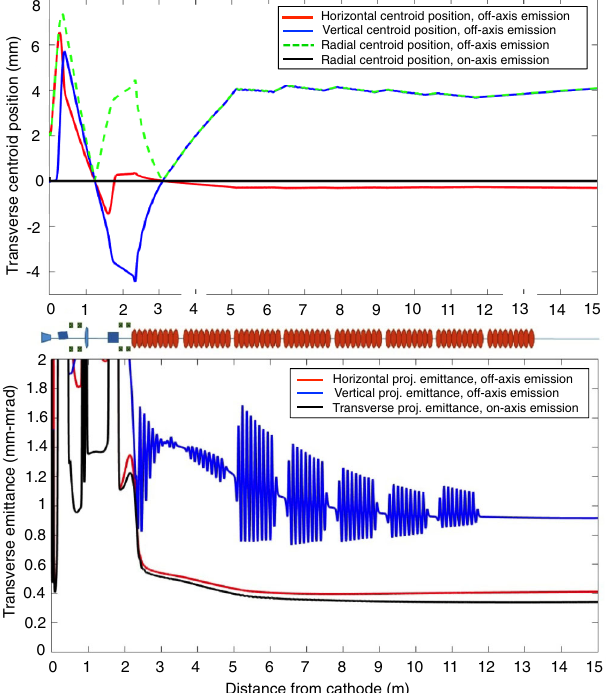
FIG. 4. Evolution of the transverse centroid (upper) and trans- verse emittance (lower) along the length of the injector system of Fig. 1. The red and blue lines are, respectively, the horizontal and vertical results for a beam emitted 2.0 mm horizontally off-axis. Results for the on-axis beam are shown in black.